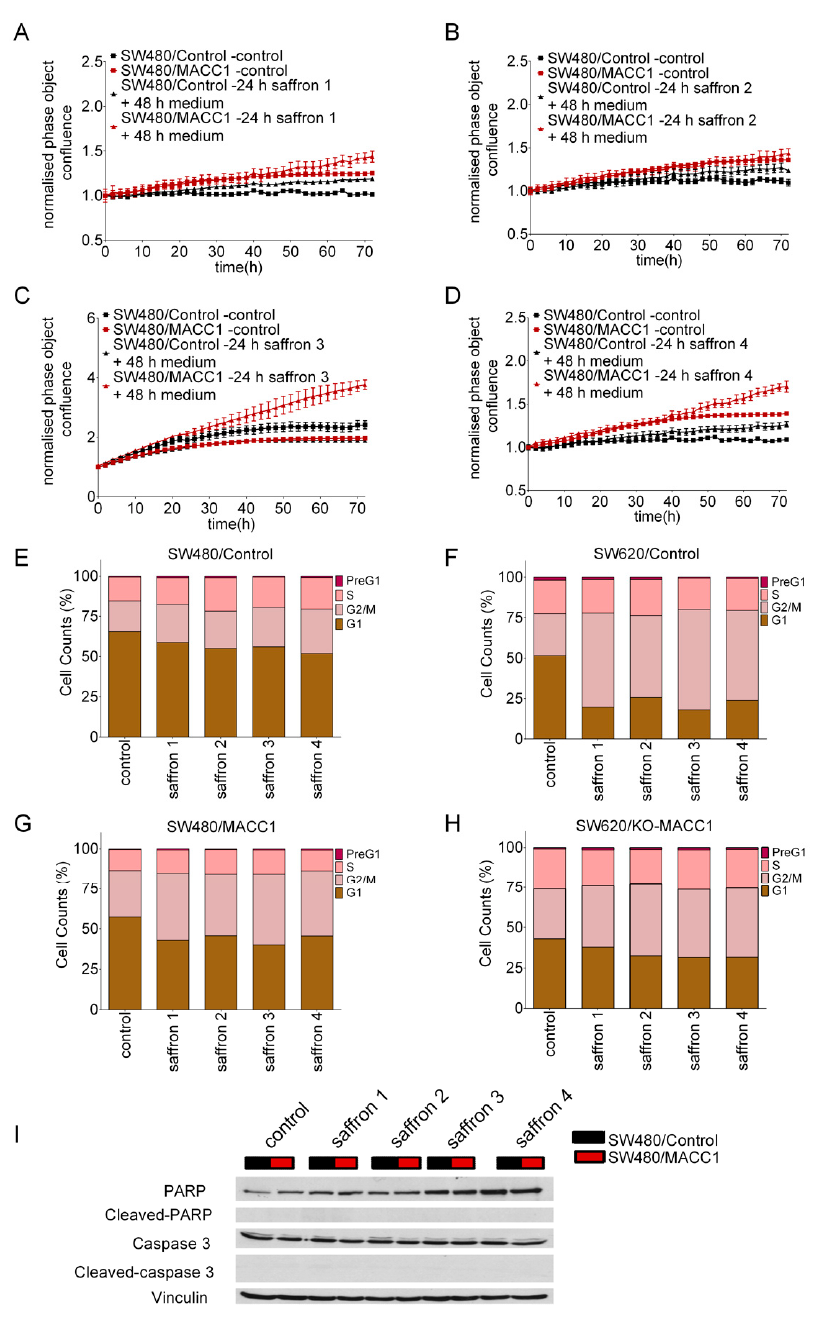
Figure 3. Sa ff ron treatment led to cell cycle arrest upon MACC1 expression. Replacement of sa ff ron-medium with sa ff ron-free medium after 24 h increased the proliferation of CRC cells with high MACC1 expression. As a control, the cells were treated with freshly prepared sa ff ron dilutions after 24 h ( A – D ). In agreement with the rescue experiment, via PI staining the cell cycle distribution of the cells was investigated. Twenty-four hour sa ff ron exposure increased the cell portion at G2 / M phase in MACC1 overexpressing CRC cells ( E – H ). Forty-eight hours of sa ff ron treatment did not increase